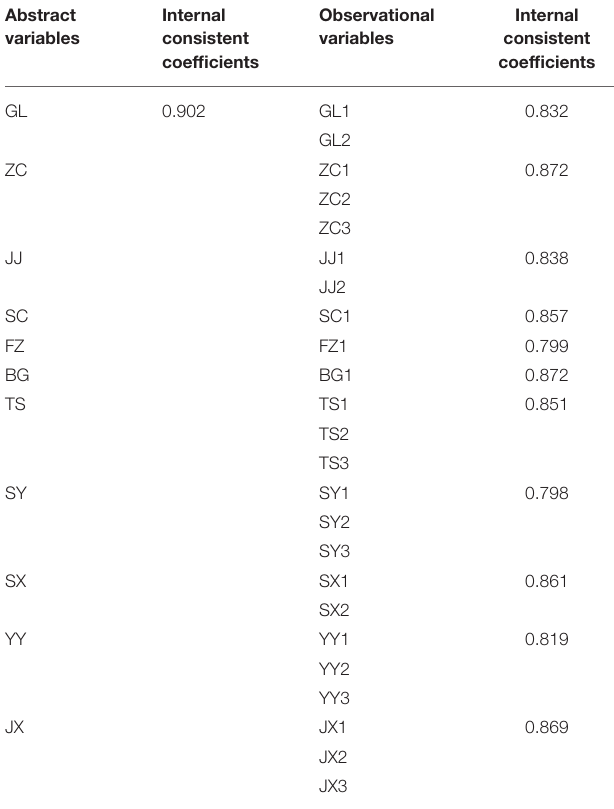
TABLE 5 | Test results of